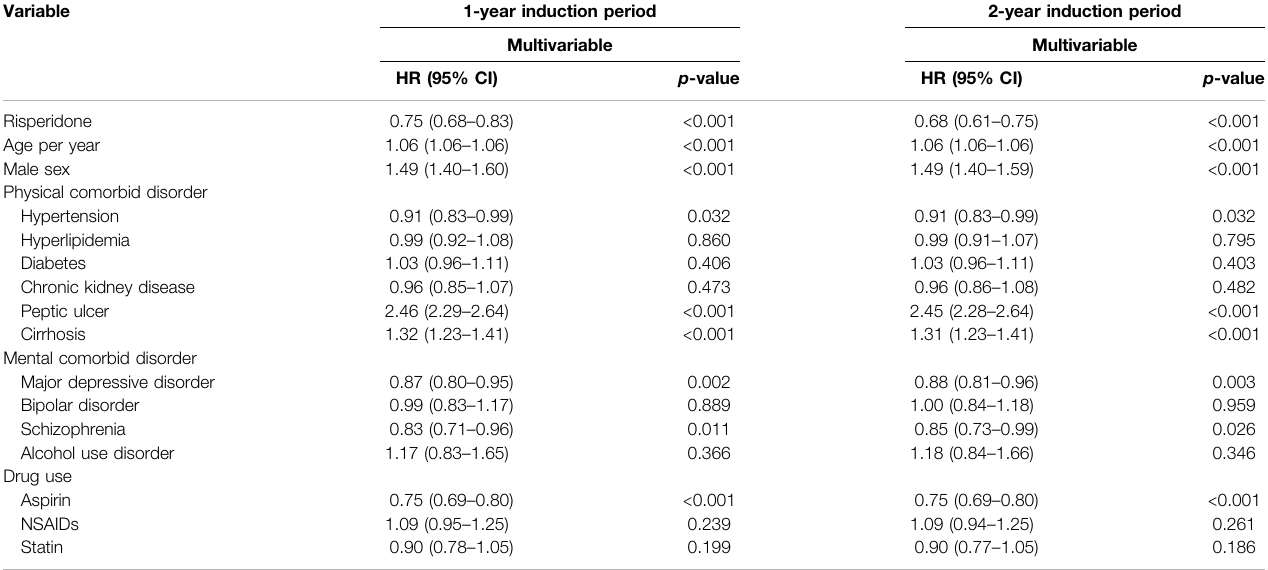
TABLE 2 | Cox proportional hazard regression model analysis for risk of gastric cancer in the population-based